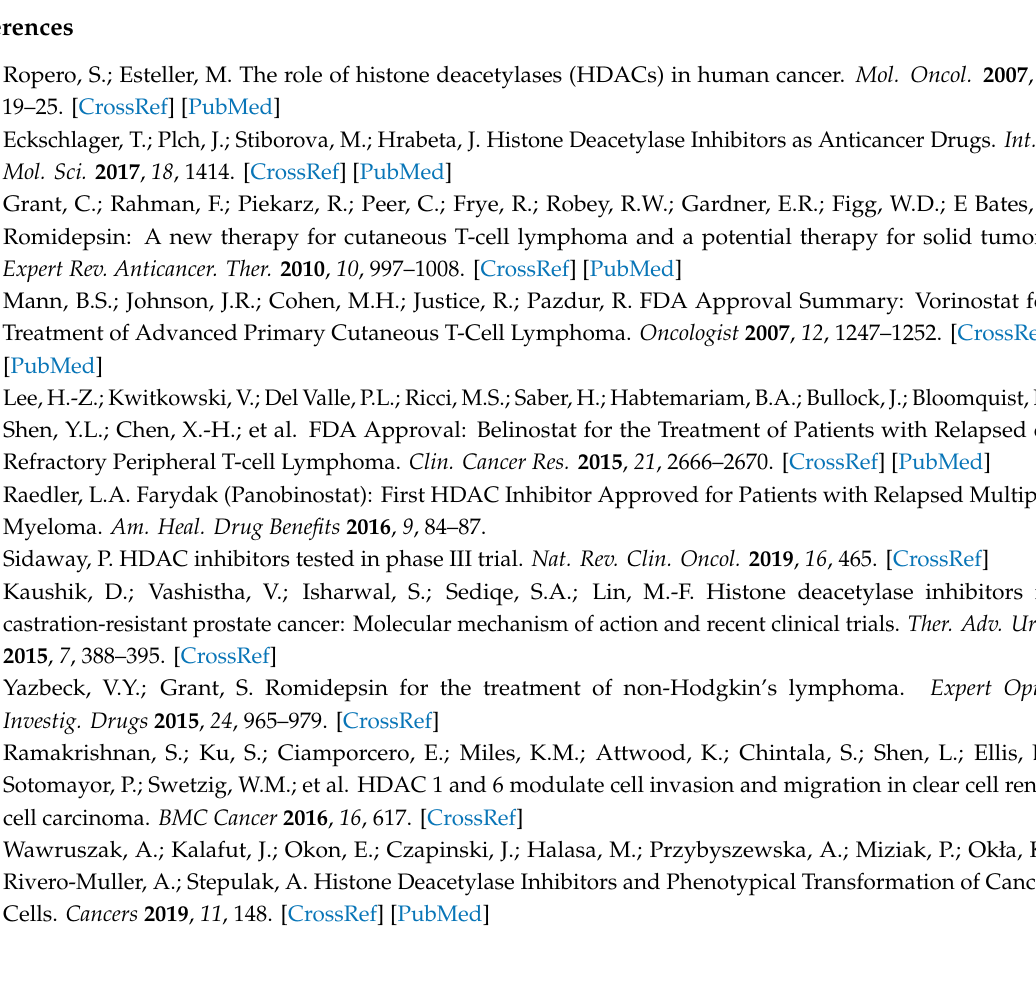
Drug-drug interactions measured in 2D cultured Caki-1 cells; Figure S10: Drug-drug interactions measured in 3D cultured Caki-1 cells; Figure S11: Anti-angiogenic activity of the ODC in vitro and in vivo; Table S1. Information on all drugs used for the TGMO-based screen; Table S2. Genetic distinction between cell lines and the description of –SR cells; Table S3. Doses in clinical use for panobinostat (pan), vorinostat (vor), axitinib (axi), pictilisib (pic) and saracatinib (sar); Table S4. Combinatorial Index of three drug combination panobinostat (pan), vorinostat (vor), axitinib (axi) at various doses; Table S5. Cross-validation of ODC in ccRCC and non-cancerous cell lines doses; Table S6. 35 highest expressed transcripts of Caki-1 cells validated through RNA sequencing; Table S7. RNA expression of saracatinib (sar), pictilisib (pic), axitinib (axi) or crizotinib (cri) drug targets in Caki-1 and Caki-1-SR clone 1 cells.; Table S8. HDACI combined with immune -modulatory regimens in clinical trials.; Table S9. Side e ff ects of panobinostat (pan), vorinostat (vor), axitinib (axi) and pictilisib (pic) reported in the cardiovascular, central nervous, endocrine and gastrointestinal system and potential cross activities. References [85–107] are cited in the Supplementary